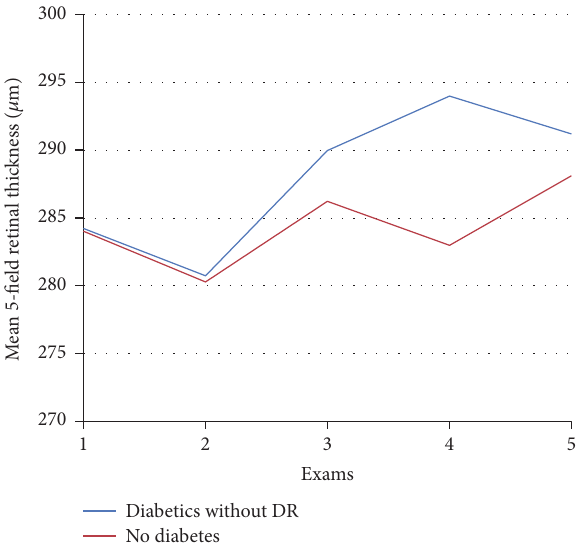
Figure 4: Mean retinal thickness of the macular 5 fields on optical coherence tomography in 𝜇 m before (exam 1) and after cataract surgery: 1st day (exam 2), 1 month (exam 3), 3 months (exam 4), and 6 months (exam